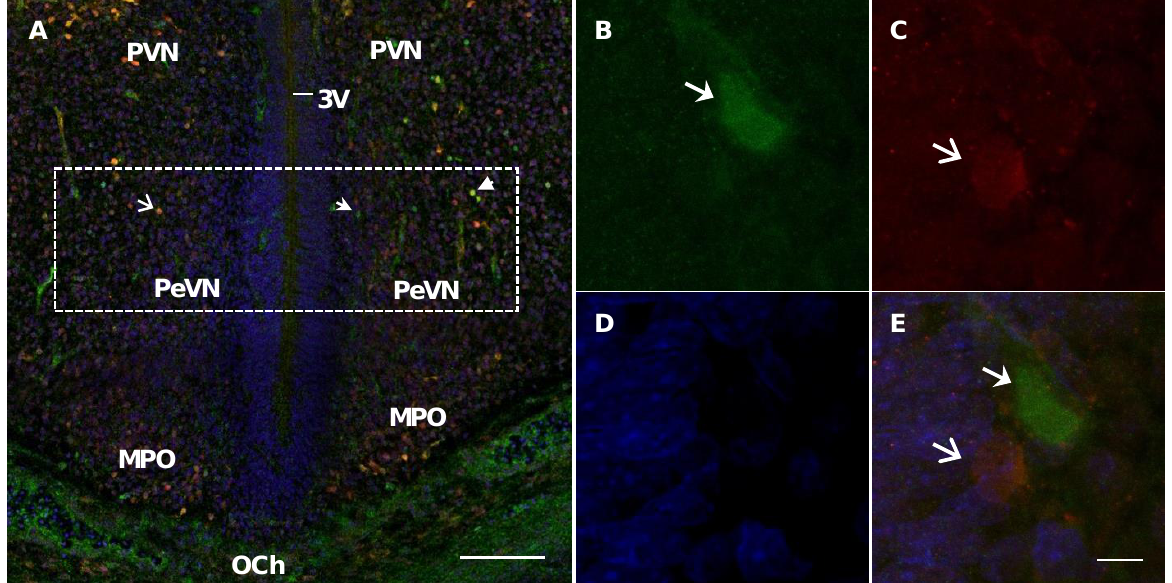
Figure 3. Confocal microscopy of the periventricular nucleus (PeVN) (frontal sections) of the rat on embryonic day 18. ( A ), general view of the PeVN (dotted frame) with sparse neurons (arrows), weakly immunopositive for either tyrosine hydroxylase (TH, green) or aromatic L-amino acid decar- boxylase (AADC) (red). ( A , B , E ), neurons, immunopositive for TH, but immunonegative for AADC (green, arrow); ( A , C , E ), immunopositive for AADC, but immunonegative for TH (red, open arrow); ( A ), immunopositive for both enzymes (yellow, arrowhead). ( D ), cells with nuclei stained with DAPI (blue). 3V, 3rd cerebral ventricle; MPO, medial preoptic nucleus; OCh, optic chiasma; PVN, paraventricular nucleus. Bar: ( A )—100 µ m, ( B – E )—5 µ